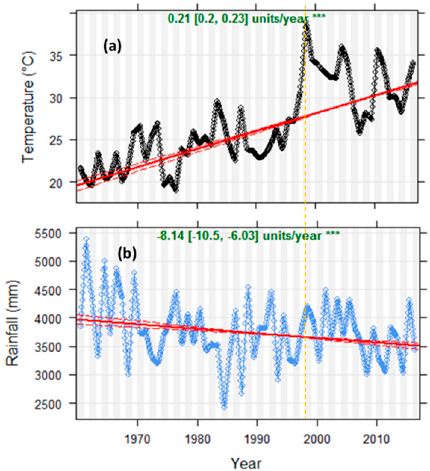
Figure 9. Shows the long-term trend of monthly temperature ( a ) and rainfall ( b ). The solid red line Figure 9. shows the long-term trend of monthly temperature ( a ). and rainfall ( b ). The solid red line